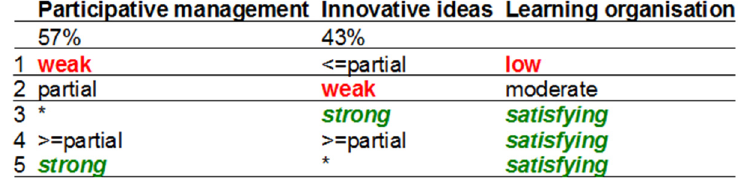
Figure A5. Utility function of the aggregated attribute Social Forces.